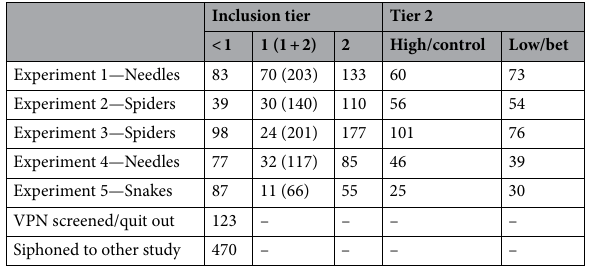
Table 1. Inclusion tiers and sample sizes for experiments 1–5. Tier < 1 = excluded from all analyses or for separate study, Tier 1 = included in sensitivity analyses, Tier 2 = most stringent inclusion for main analyses